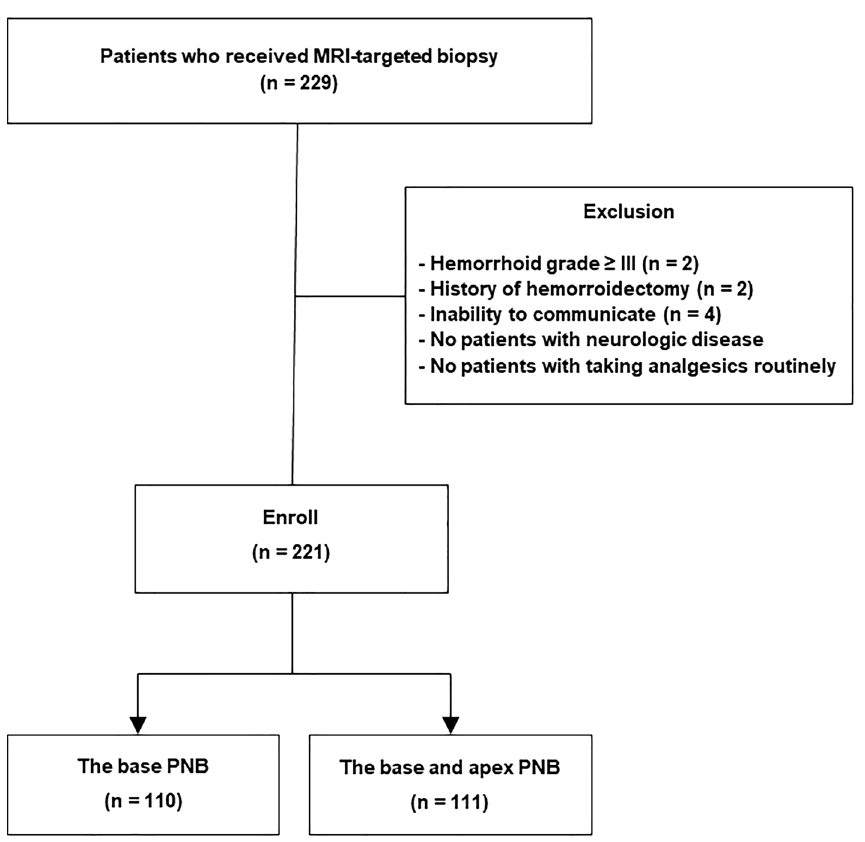
Figure 2. Study cohort flow diagram. MRI magnetic resonance image, PNB periprostatic nerve block, TRUS transrectal